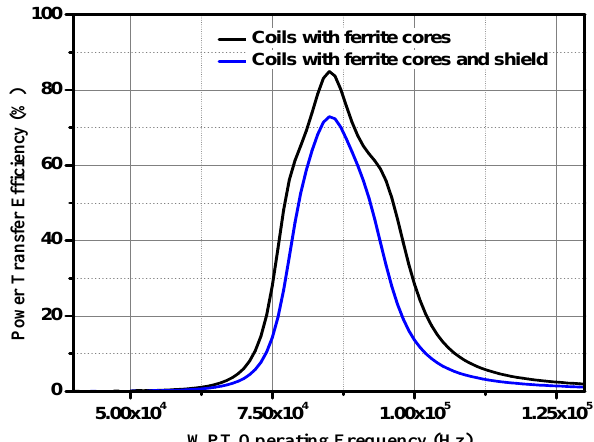
Figure 12. System performances for coils with ferrite cores and with ferrite and Al plates.